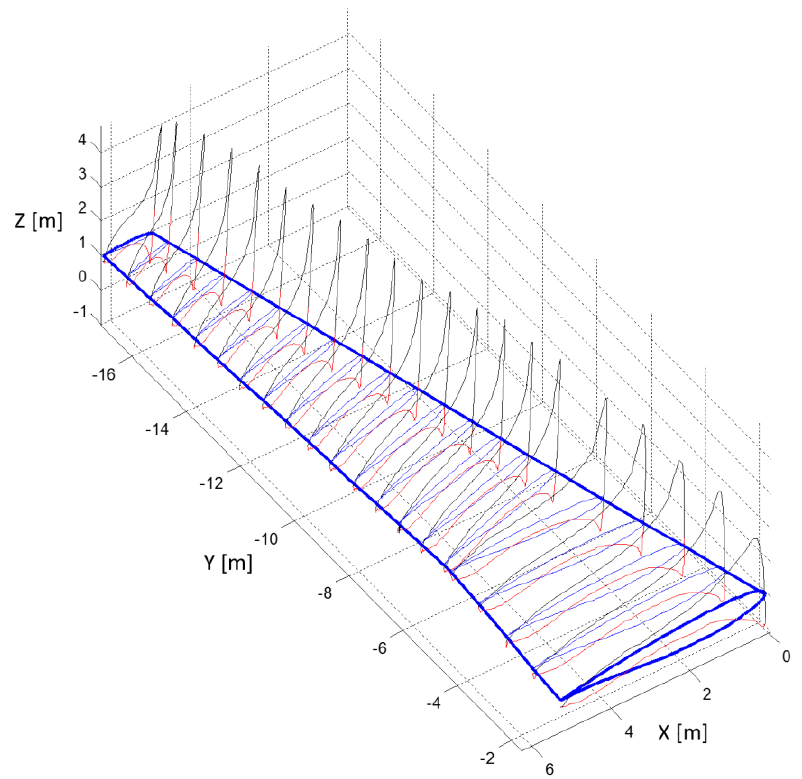
Figure 7. Pressure distribution along the strips of the aerodynamic model (left wing).